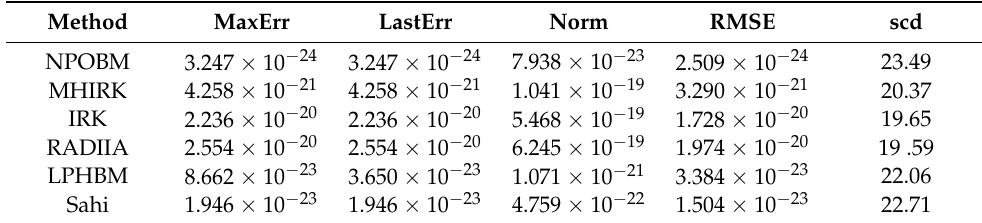
Table 2. Numerical results for Problem 1 with NS = 10 3 where x ∈ [ 0,2 ] .